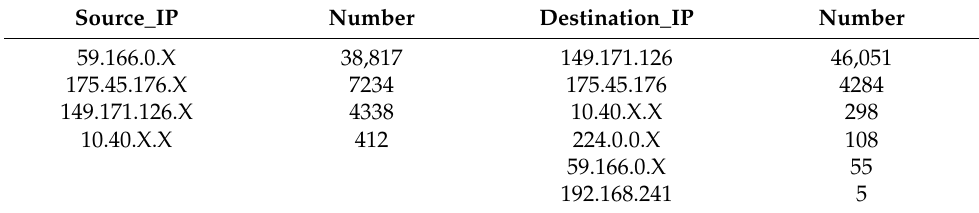
Table 4. Distribution of source and destination IP addresses.